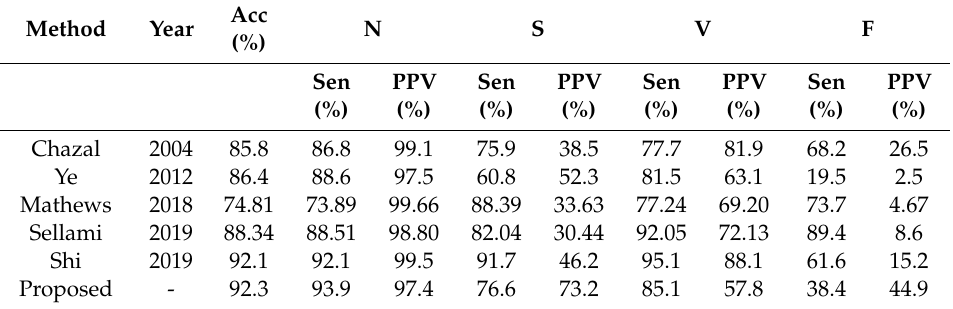
Table 8. Comparison of the results between the proposed method and previous works. Normal heartbeat (N), supraventricular ectopic heartbeat (S), ventricular ectopic heartbeat (V), and fusion heartbeat